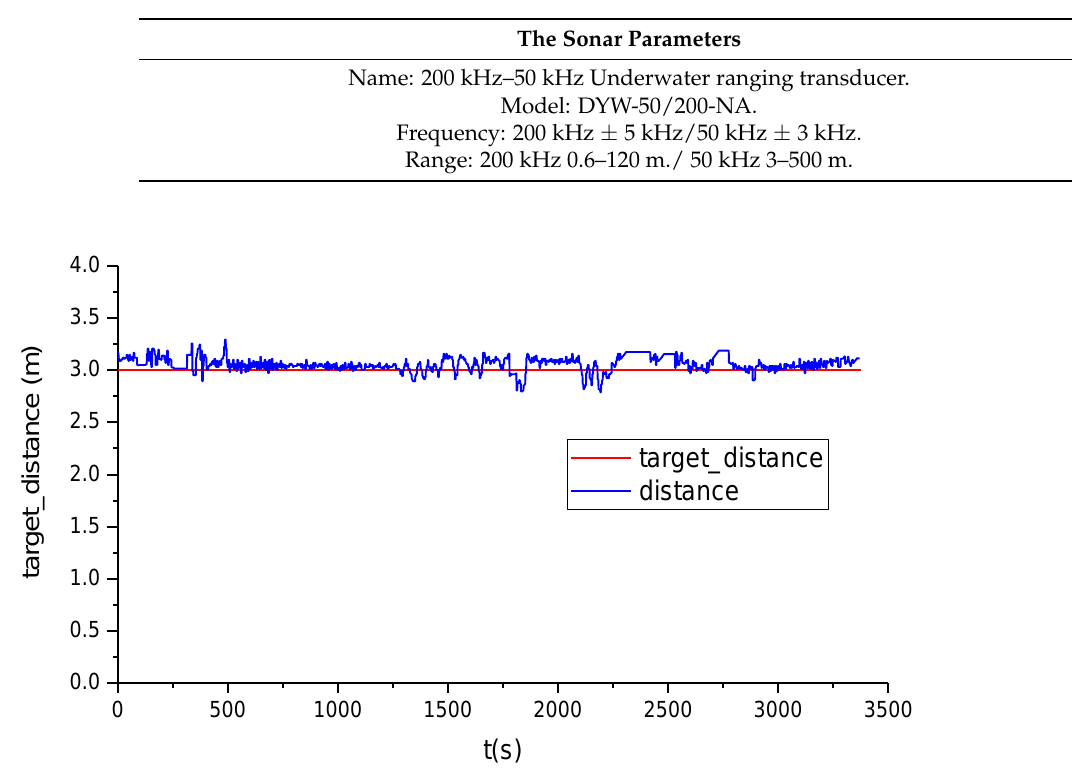
Figure 14. The ranging sonar. Table 2. The sonar parameters.